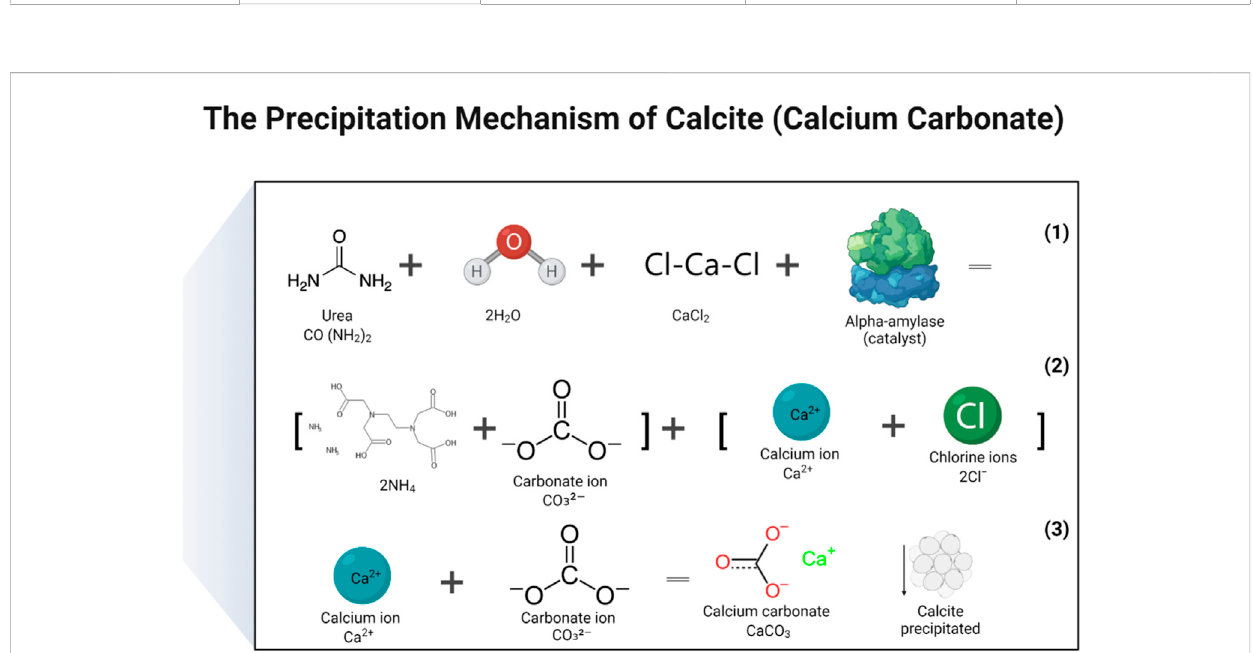
Reactions that have been carried out to produce a precipitate of calcium carbonate